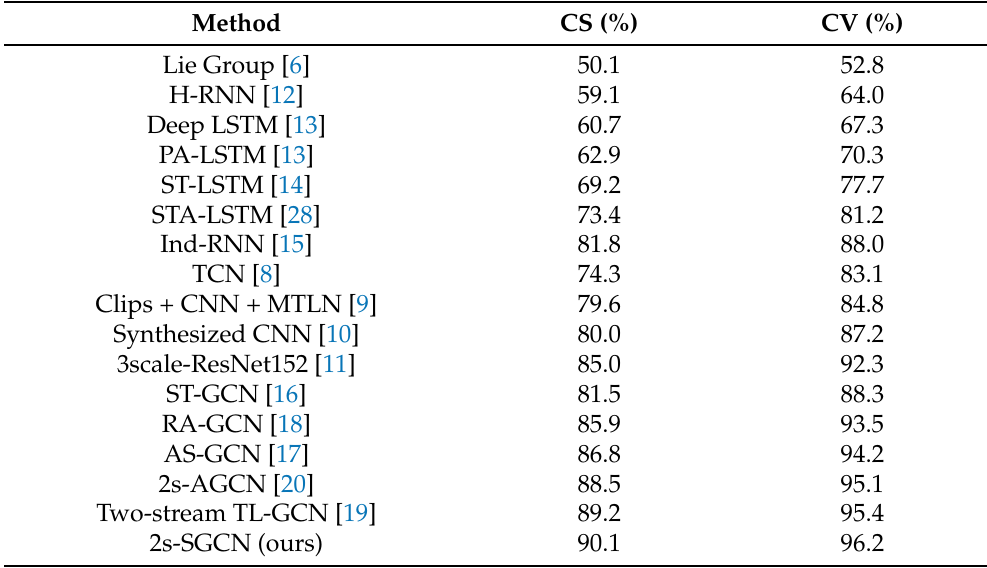
Table 5. Comparisons of the validation accuracy with state-of-the-art method on the NTU- RGB+D dataset.